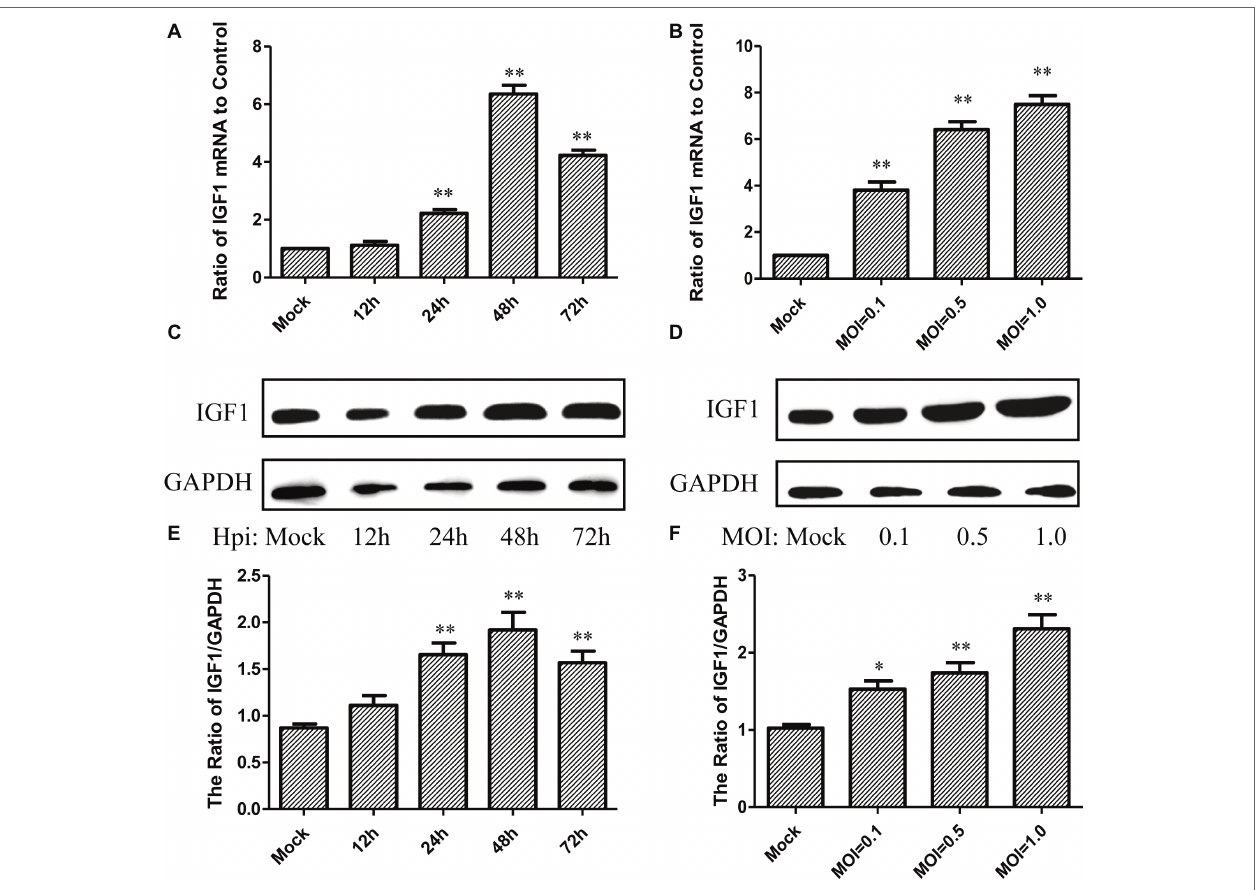
FIGURE 1 | IGF1 expression was upregulated in A549 cells infected with influenza A virus (IAV) PR8. (A) Changes in the level of IGF1 mRNA over time in PR8- infected A549 cells (MOI = 0.5); (B) changes in the level of IGF1 mRNA over MOI in PR8-infected A549 cells at 48 h post-infection; (C) changes in the level of IGF1 protein expression over time in PR8-infected A549 cells (MOI = 0.5); GAPDH was used as loading control, and figures were representative of three independent experiments; (D) changes in the level of IGF1 protein expression over MOI in PR8-infected A549 cells at 48 h post-infection; GAPDH was used as loading control, and figures were representative of three independent experiments; (E) grayscale analysis of Figure 1C, and plotted as the ratio of the integrated density of IGF1/ GAPDH; (F) grayscale analysis of Figure 1D, and plotted as the ratio of the integrated density of IGF1/GAPDH. Data were the means ± SD from three independent experiments. ** p < 0.01 vs. Mock by t